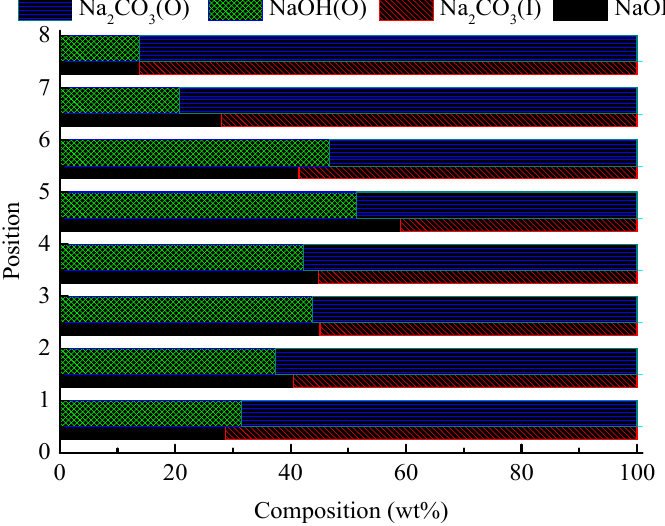
Figure 8. Composition of the molten salts after reacting for 11 h (temperature: 400 ◦ C, plate position: 45 mm, superficial gas velocity: 2.95 mm /